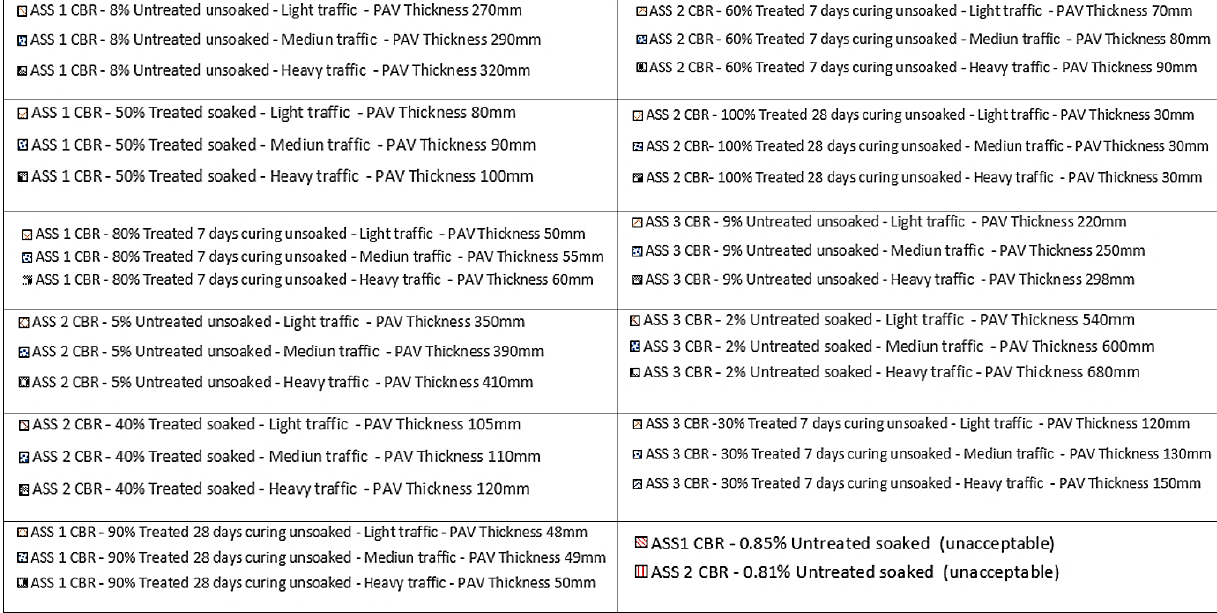
Figure 14. Road pavement thickness optimization using the chart for pavement thickness determination.